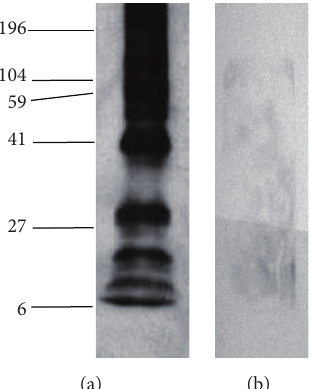
Figure 1: Immunoreactivity against isolated antigens. Representative western blot analysis of PyL antigens obtained through immunoaffinity chromatography with immobilized IgGs from malaria surviving ICR mice. (a) shows the specificity of immune sera from ICR mice against purified antigens followed by the incubation with the secondary antibody anti-mouse IgG/HRP linked Fab and (b) was incubated only with the secondary antibody. Lanes were loaded with 10 𝜇 g of protein.